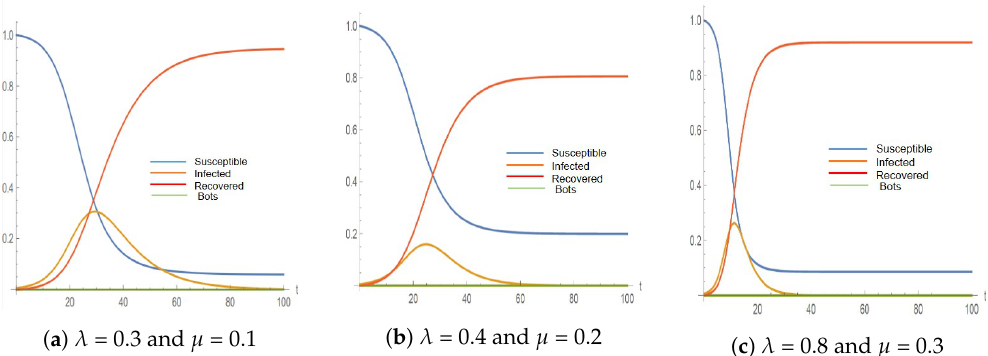
Figure 3. The simulation results for SIR model using different rates on the 2011 dataset (a is the best